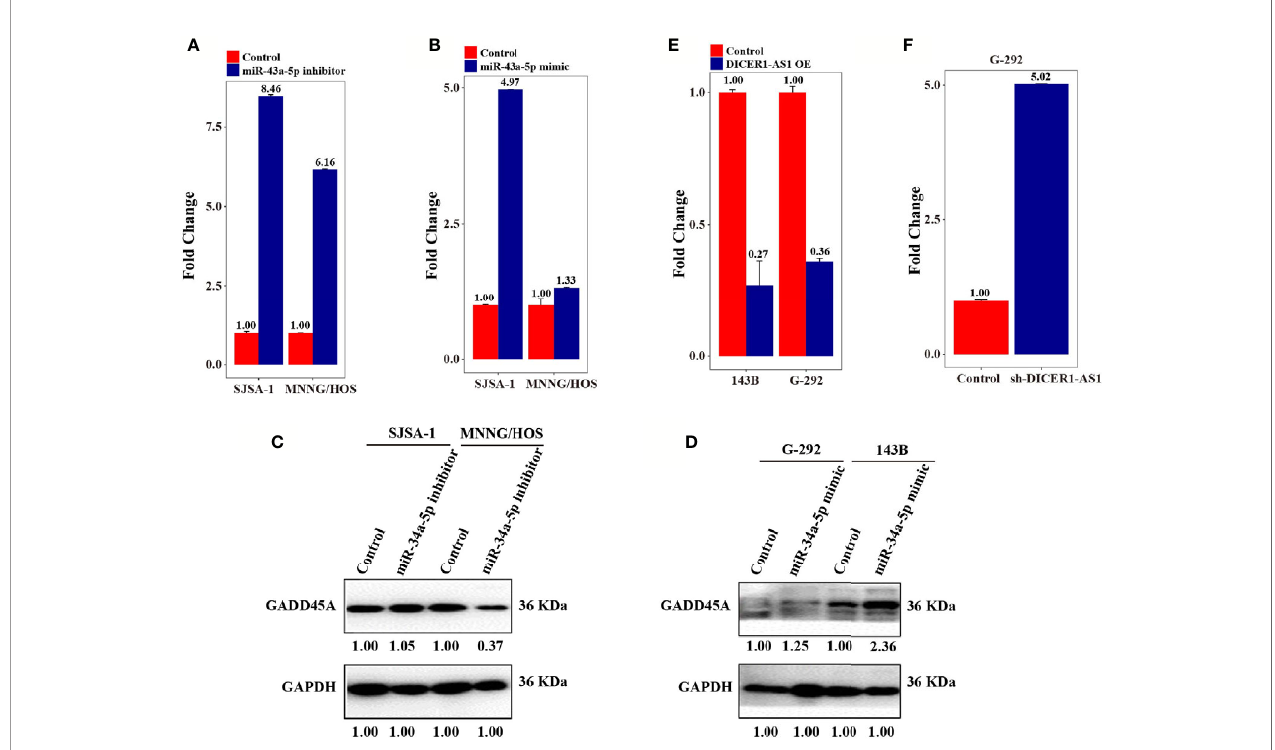
FIGURE 6 | DICER1-AS1/miR-34a-5p/GADD45A involved in Cell cycle/pRb-E2F signaling pathway. (A) GADD45A mRNA level in the miR-34a-5p inhibitor- transfected SJSA-1 and MNNG/HOS cells versus the negative control (NC), as determined by qRT-PCR analyses. (B) GADD45A mRNA level in the miR-34a-5p mimic-transfected G-292 and 143B cells versus the negative control (NC). (C) The relative GADD45A expression level in SJSA-1 and MNNG/HOS cells infected with miR-34a-5p inhibitor versus the negative control (NC). (D) The relative GADD45A expression level in G-292 and 143B cells infected with miR-34a-5p mimics versus the negative control (NC). (E) The relative GADD45A expression level in SJSA-1 and MNNG/HOS cells infected with DICER1-AS1-OE versus the negative control (NC-OE). (F) The relative GADD45A expression level in G-292 cells infected with shDICER1-AS1versus the negative control